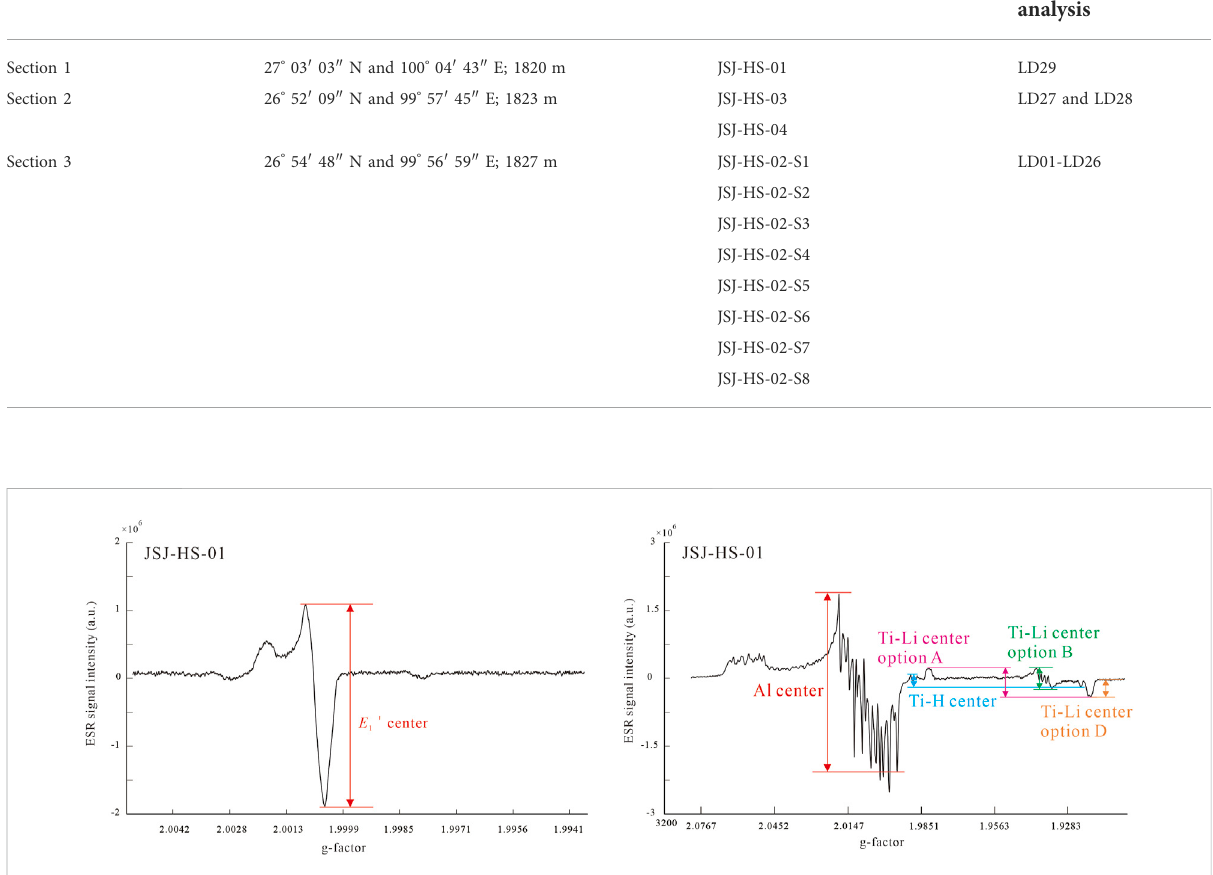
FIGURE 6 ESR spectra ofthe E 1 ʹ centermeasuredatroomtemperaturefor Aland multiple Ticentersmeasured atalowtemperature (77 K) insample JSJ-